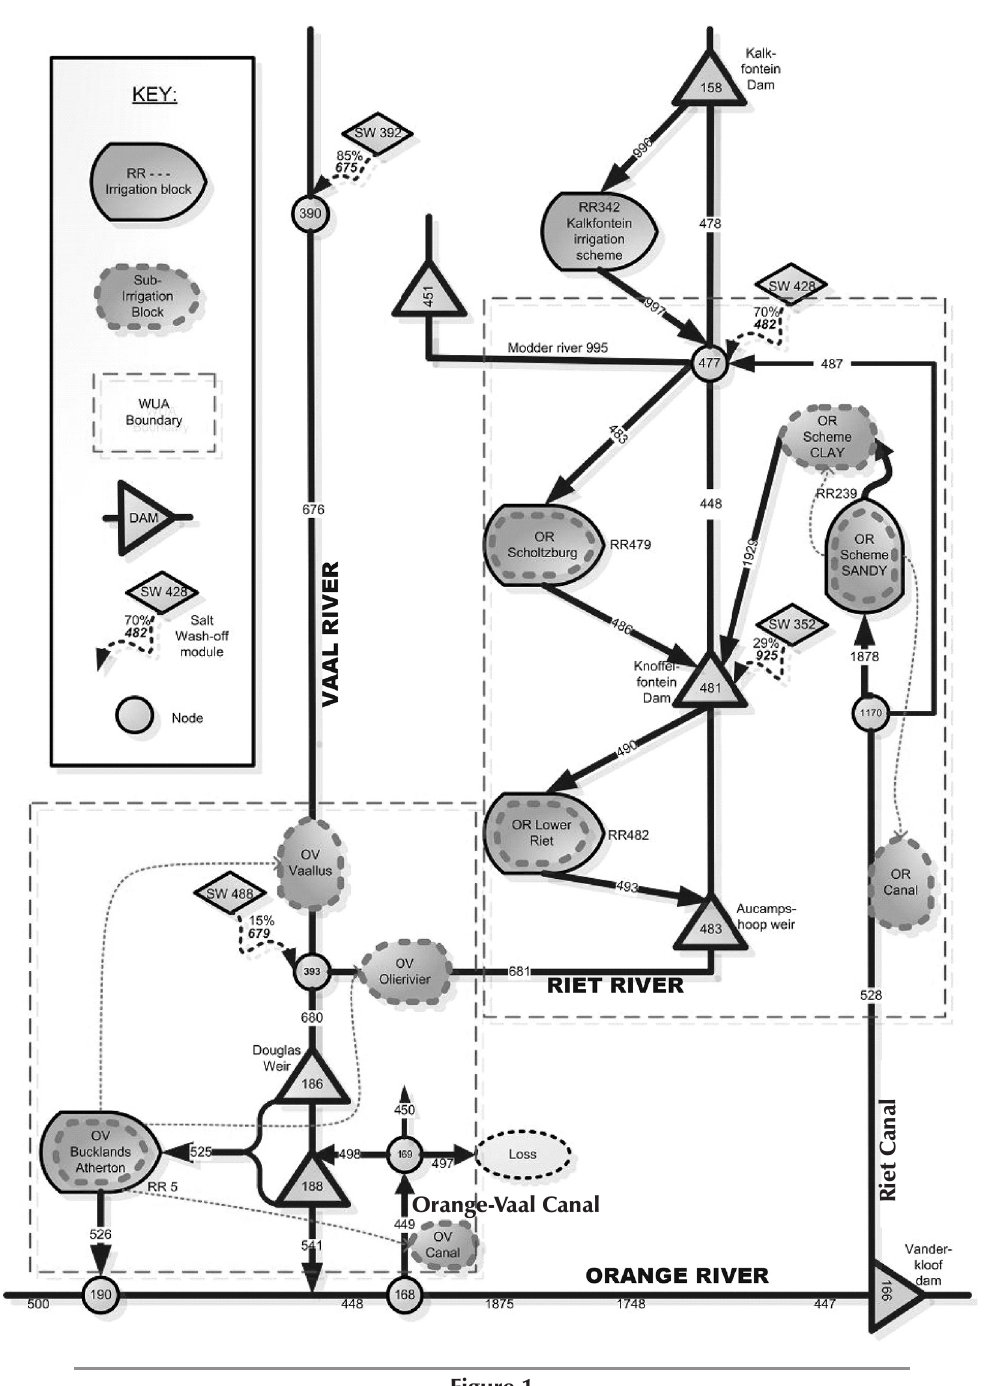
A simplified diagram of the WRPM hydrology set-up of the study area (indicating channels, nodes, irrigation blocks, WUAs and sub-irrigation blocks)